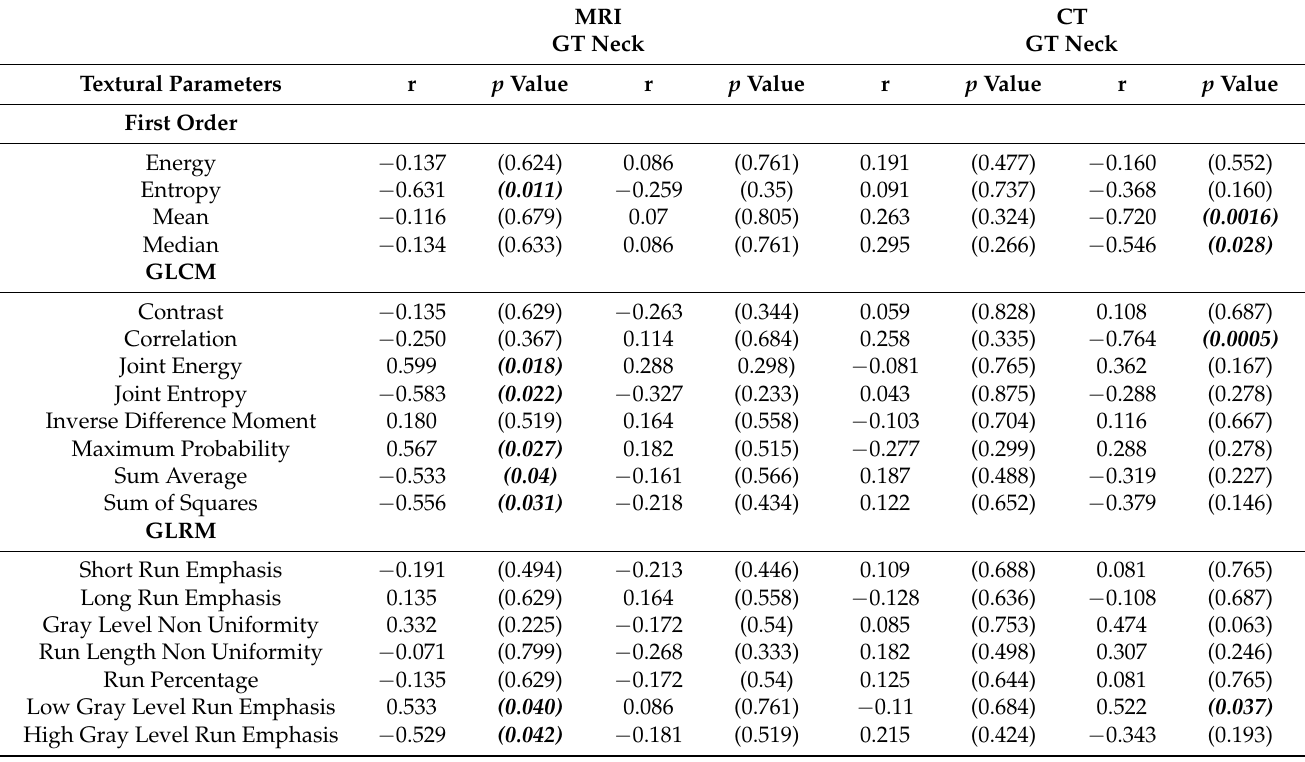
Table 3. Correlation between textural parameters and aBMD for the greater trochanter and neck in the MR images and for the greater trochanter and the neck in the CT images. In bold and italic, p -value under 0.05. (GT = greater trochanter). (aBMD: areal bone mineral density; GLCM: grey level coocurrence matrix; GLRM: grey level run-length